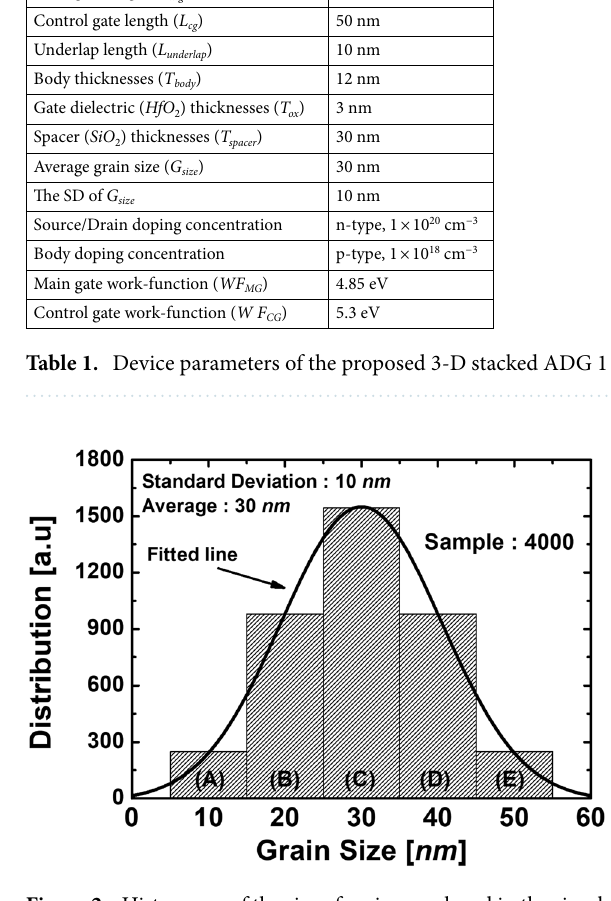
Figure 2. Histograms of the size of grains employed in the simulation work. The variations of the size of grains are generated from the Gaussian distribution. The average and SD for the Gaussian distribution are 30 nm and 10 nm, respectively.